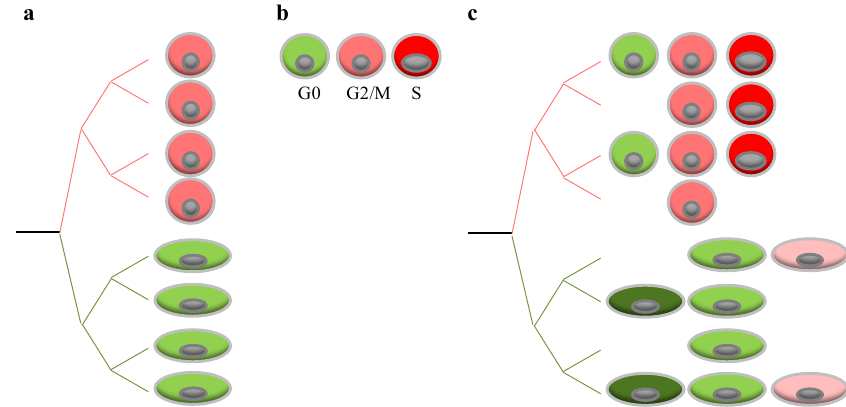
Figure 3. Single cell analysis and impact of cell-to-cell variability on virus replication . ( a ) Cell population may contain multiple cell subsets, displaying high (red) and low (green) susceptibility to viral replication; ( b ) cell population may contain cells in different states (differentiation, cell cycle), affecting their susceptibility to viral infection. For example, cells in the S phase might display high levels of susceptibility to viral infection (red) while cells in G0 a low susceptibility to infection (green); and ( c ) complexity of cell population when cellular heterogeneity is a mixture of cells of multiple subsets, in multiple states, and in different